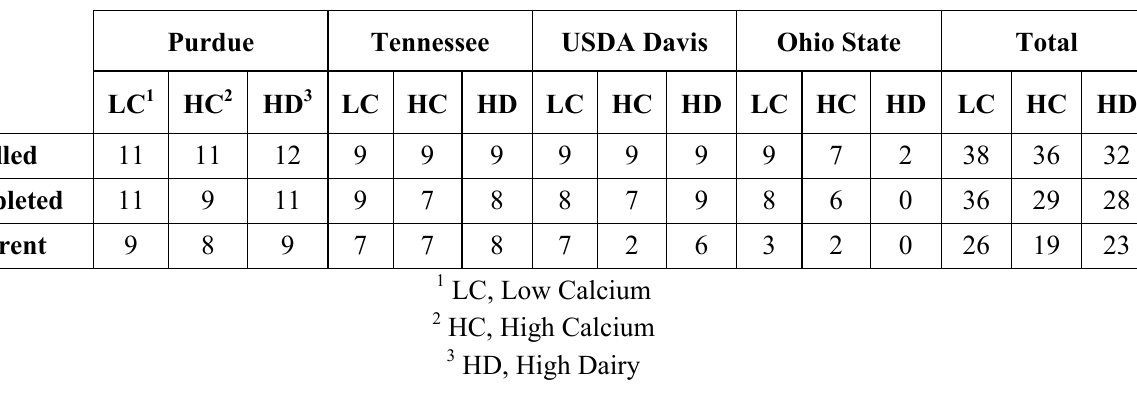
Table 1. Distribution of Subjects.